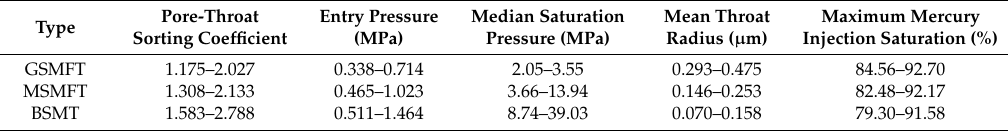
Figure 6. Representative capillary pressure curves of the good sorting and micro-fine throat (GSMFT), moderate sorting and micro-fine throat (MSMFT), and bad sorting and micro throat (BSMT) types of pore-throat structure. Table 2. Characteristic parameters of different pore-throat structure types.